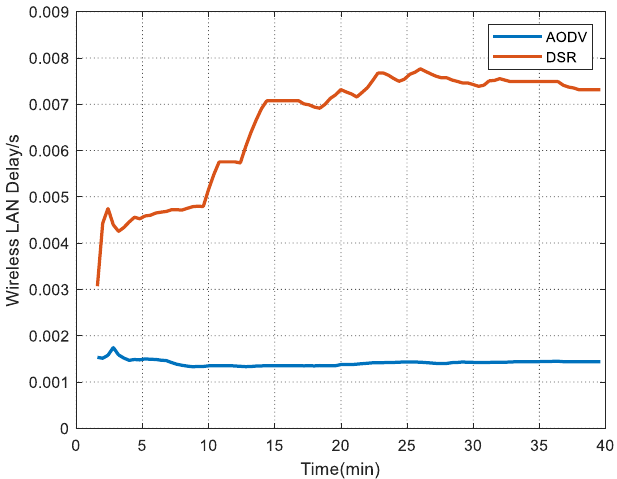
Figure 5. Wireless LAN delay comparison of AODV and DSR routing protocols.